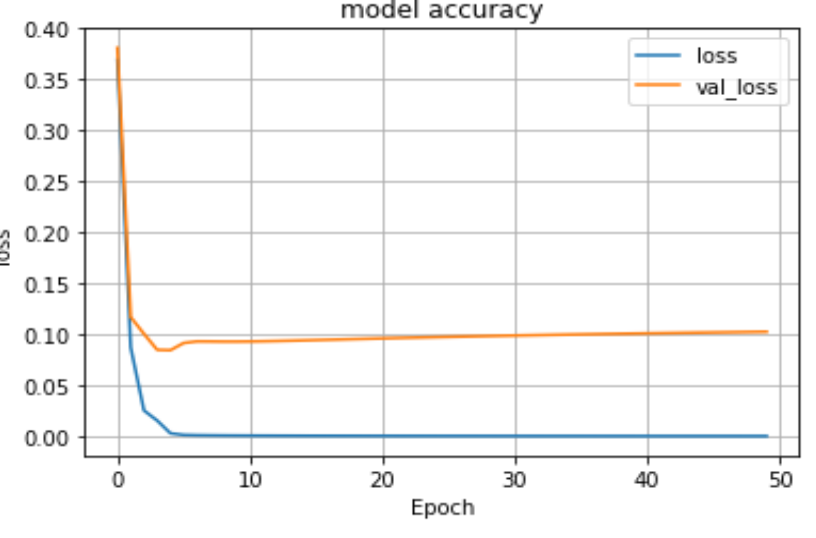
Figure 5. C3-enabled CNN LSTM model loss.